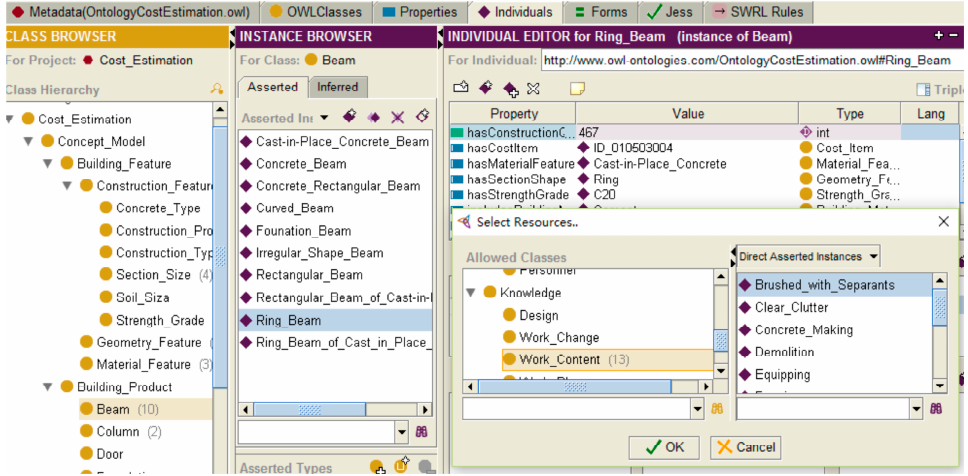
Figure 11. Protégé ‐ OWL screenshot of object property data of beam input. Figure 11. Protégé-OWL screenshot of object property data of beam input. Future Internet 2016 , 8 , 39